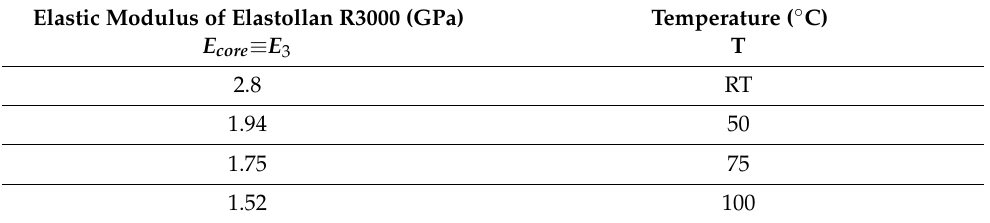
Table 6. Modules of Elastollan R3000 at wide range of temperatures are extracted from Figure 5 in Ref.